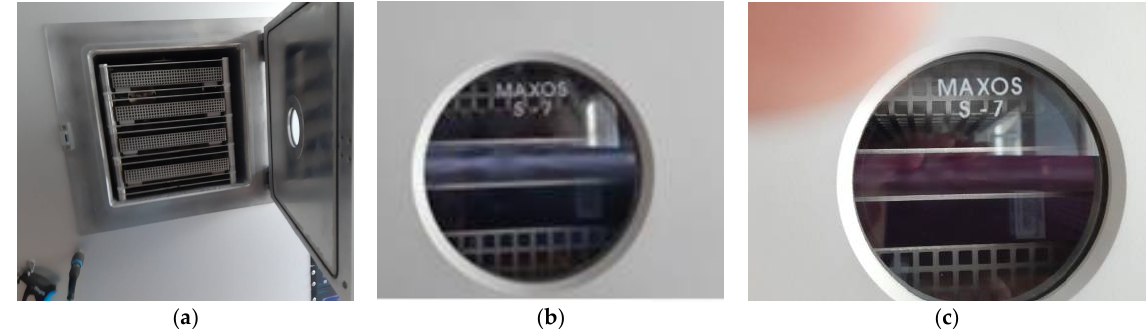
Figure 1. RF plasma O 2. ( a ) vacuum chamber with cassettes; ( b ) RF plasma O 2 using RF 1 generator 13.56 MHz; ( c ) RF plasma O 2 using RF 2 generator 40kHz.